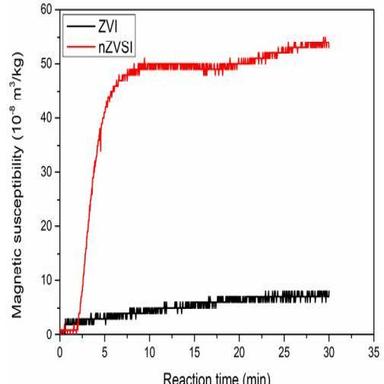
Magnetic susceptibility measured in the reactor during ZVI and nZVSI synthesis